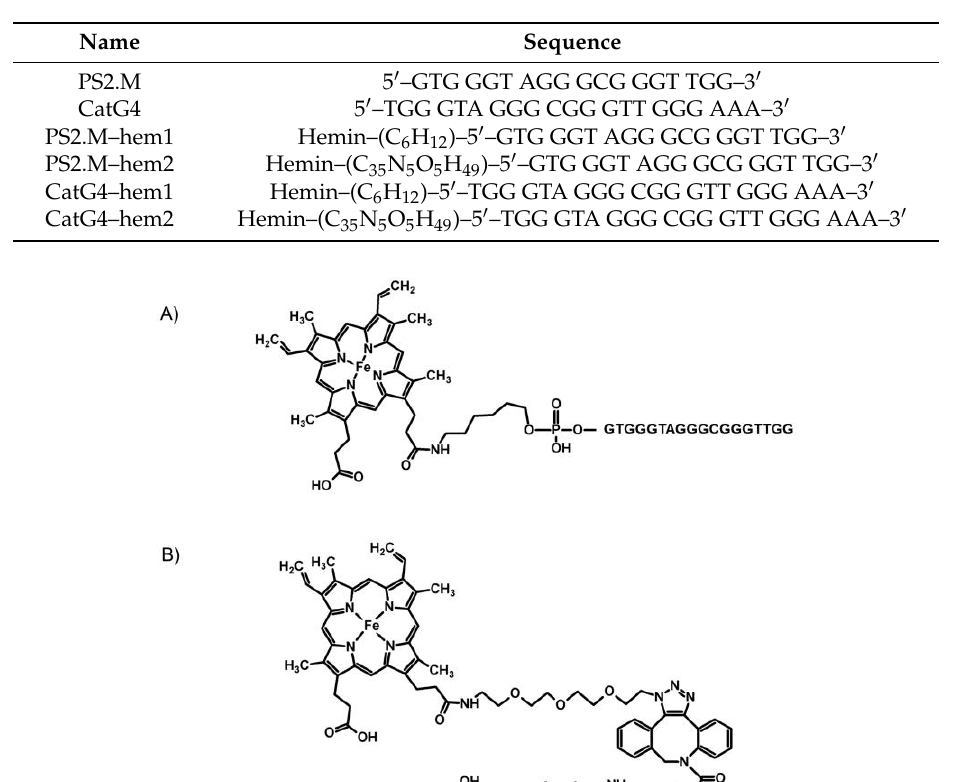
Table 1. Sequences of the oligonucleotides and conjugates used in this